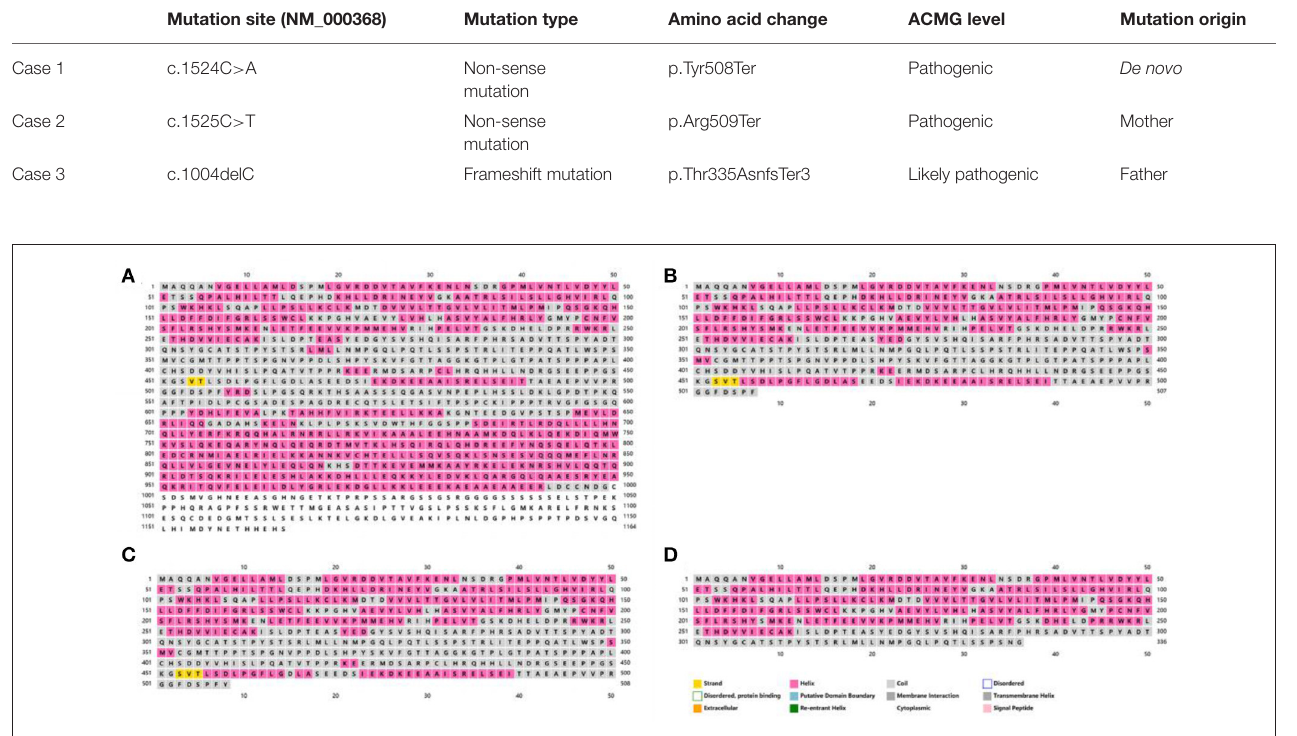
FIGURE 5 | The secondary structures of the mutated and wild-type TSC1 proteins predicted by PSIPRED V4.0. The amino acid sequences and secondary structures of (A) wild-type, (B) case 1 (c.1524C > A, p.Tyr508Ter), (C) case 2 (c.1525C > T, p.Arg509Ter) and (D) case 3 (c.1004delC,